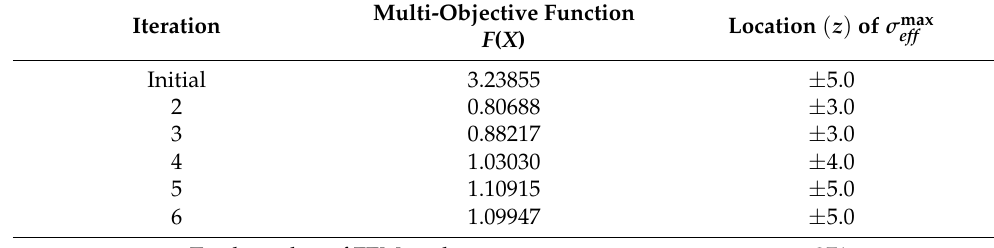
Table 5. Variation of MO function to the iteration (sym, s 1 = s 2 = 1.2 ).